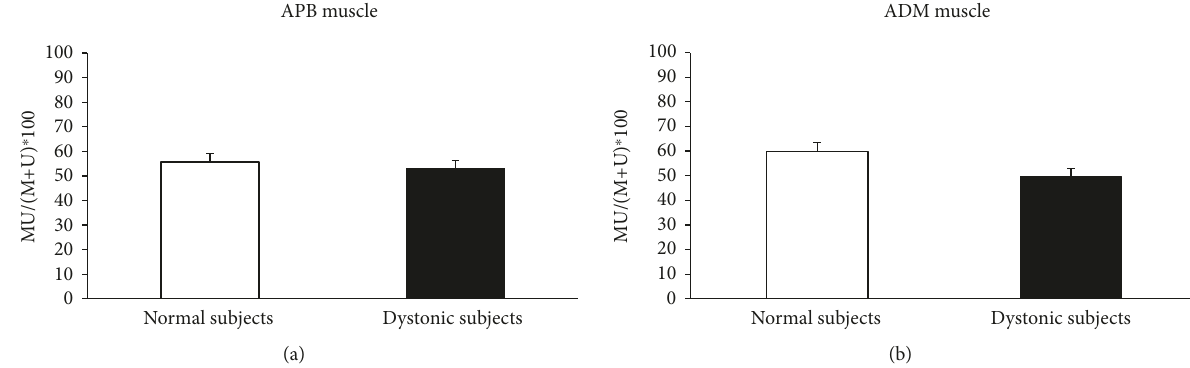
Figure 3: 5Hz rPAS did not induce any signi fi cant di ff erence between the amount of ratio MU/(M+ U) ∗ 100 after the 5 Hz rPAS between dystonic patients and controls in the APB and ADM muscles (factorial ANOVA APB: F = 0 596 , P = 0 562 (a); ADM: F = 3 493 , P = 0 07 (b)).